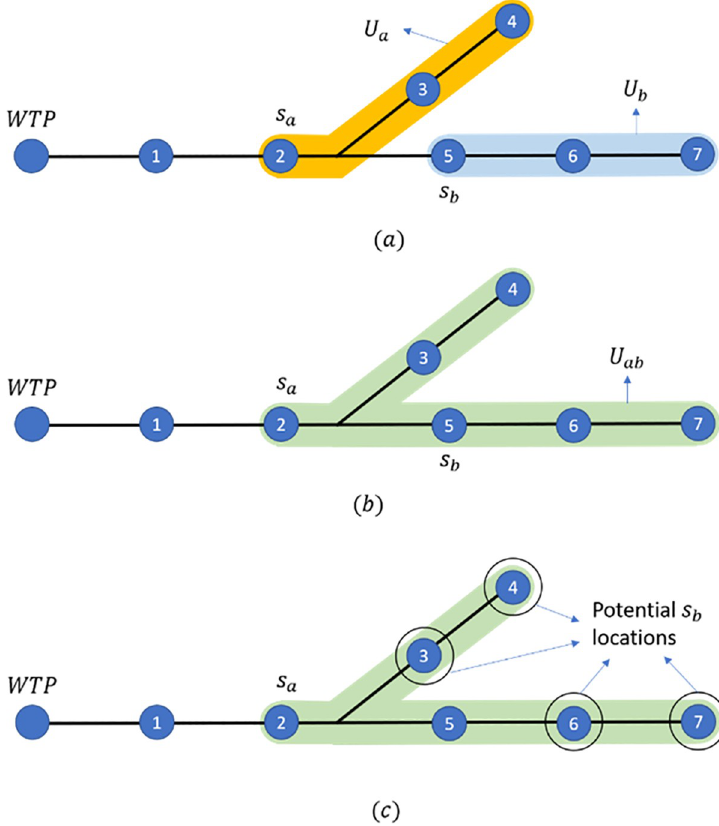
Box 2. Algorithm for the sensor location